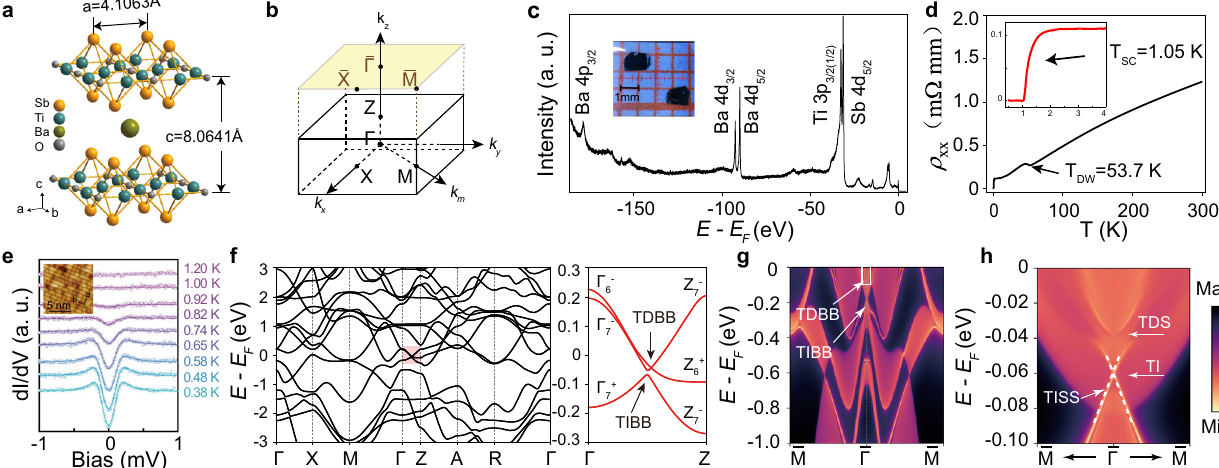
Fig. 1 Crystal structure and calculated band structure. a Crystal structure of layered BaTi 2 Sb 2 O. b Three dimensional bulk Brillouin zones (black) with (001) surface Brillouin zone (yellow) projected. High symmetry points are marked. c Core-level photoemission spectrum shows strong characteristic Ba, Ti and Sb peaks. Inset: Image of high quality BaTi 2 Sb 2 O single crystal. d Temperature-dependence of resistivity of BaTi 2 Sb 2 O. e The evolution of the STS spectra measured at temperatures from 0.38 to 1.20 K with Dynes function fi tting results. Measurement condition: V b = 1 mV, I = 100 pA, Δ V = 20 μ V. Inset: STM topographic image of the in-situ cleaved (001) surface of BaTi 2 Sb 2 O measured at 0.4 K. Measurement condition: 10 nm × 10 nm, V b = 100 mV, I = 45 pA. f Calculated band structure with SOC. The enlarged image of the red region announces the TDS and TI states. g Calculated band dispersions along Γ - M direction with bulk bands TDBB and TIBB marked. h Zoom-in of the white box in ( g ) with surface bands TDSS and bulk DP 2 + layers 75 . The bulk and (001)-projected surface Brillouin 2 Sb 2 O]